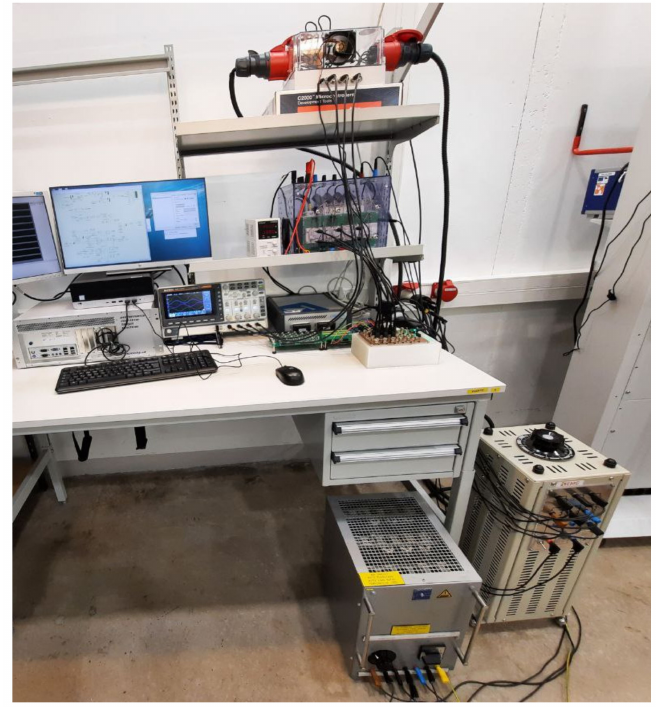
Figure 6. The setup for the current transducers box and the loading test of the inverter.